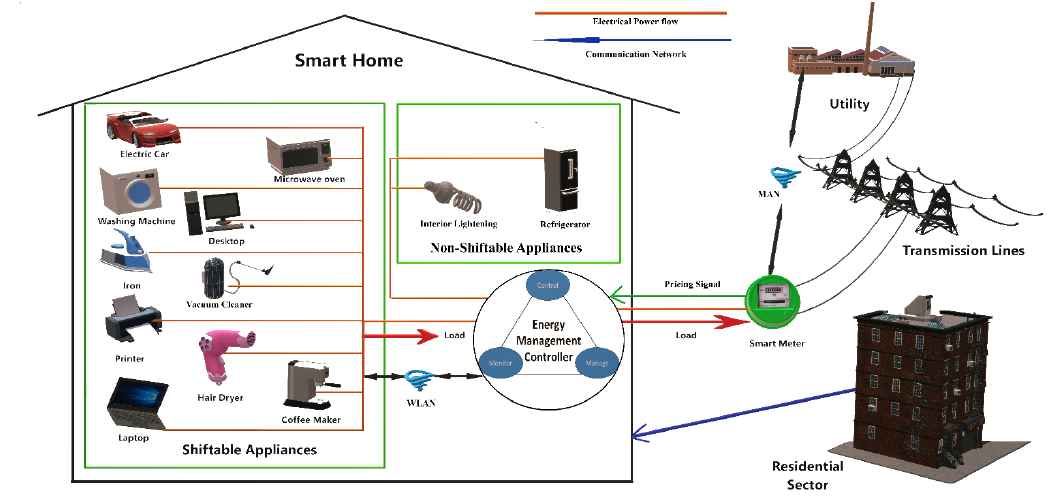
Figure 1. Proposed system